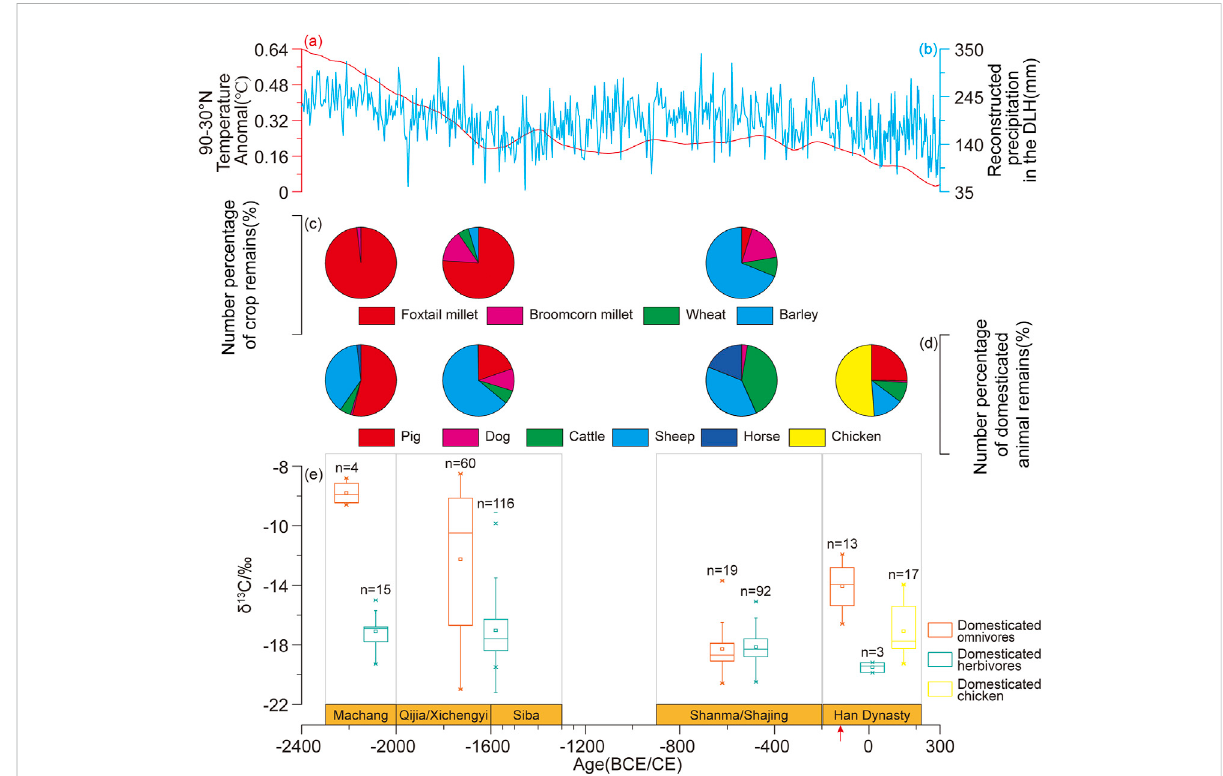
FIGURE 4 Transformation of animal utilization strategies during 2,300 BCE – 220 BCE in the Hexi Corridor, compared with climate records, crop remains, domesticated animalremainsand δ 13 Cvaluesofanimalsamples fromsitesinthestudy area. (A) NorthernHemisphere(30 ° – 90 ° )temperaturerecord compared to 1961 – 1990 instrumental mean temperature (Marcott et al., 2013). (B) Reconstructed precipitation from DLH (Delingha, Yang et al., 2021). (C) Assemblages of crop remains from sites in the Hexi Corridor. (D) Assemblages of domesticated animal remains from sites in the Hexi Corridor. (E) δ 13 C values of animal samples from sites in the Hexi Corridor. n: the number of isotopic data. Red arrow: the Han Empire controlled the Hexi corridor (121